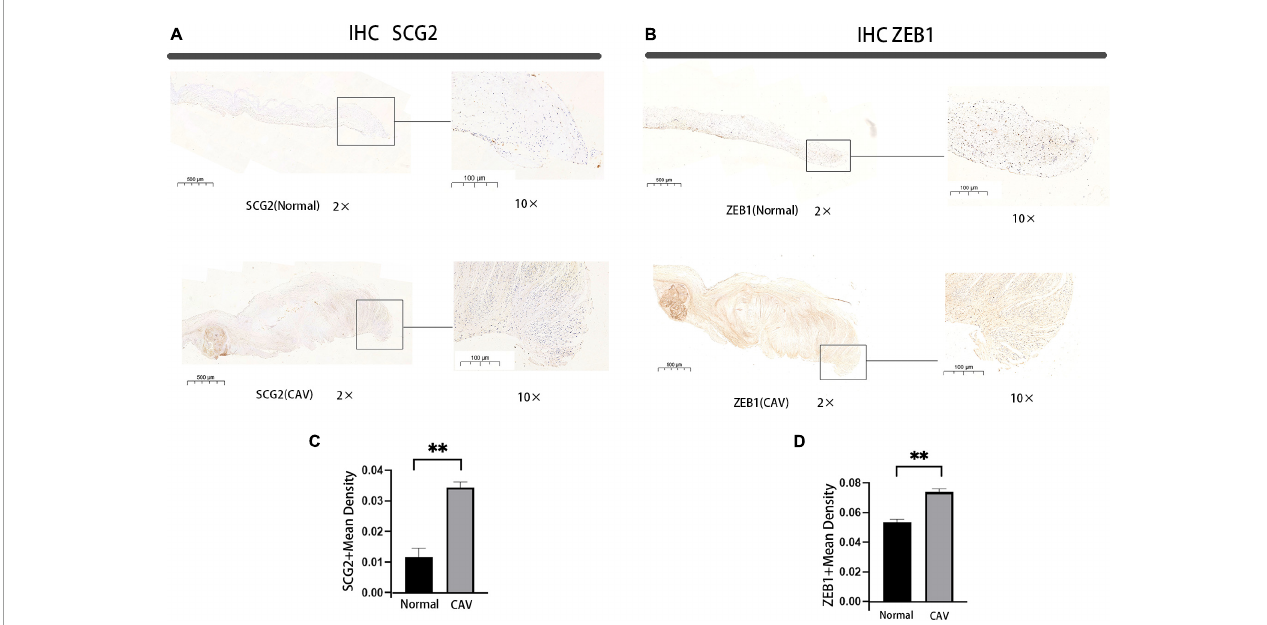
FIGURE9 Immunohistochemical staining of SCG2 and ZEB1 in human aortic valve, Bar chart for quantitative assessment of immunostaining. normal: normal aortic valve ( n = 5 biologically independent samples), CAV: CAVD patients ( n = 5 biologically independent samples). ∗ p < 0.05, ∗∗ p < 0.01 (A,B) immunohistochemical staining of the panorama of SCG2 and ZEB1. (C,D) Comprehensive quantitative expression analysis based on immunohistochemically stained